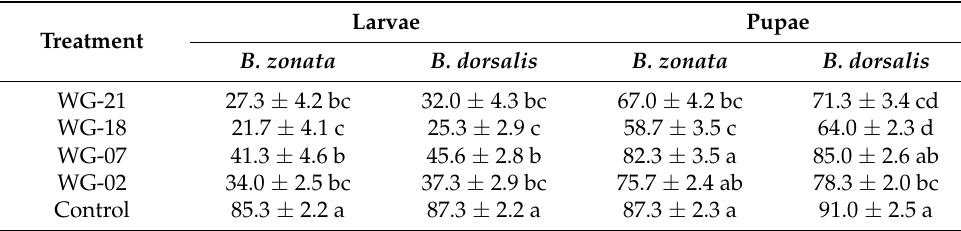
Table 10. Percent adult emergence (mean ± SEM) in B. zonata and B. dorsalis when four isolates (WG-21, WG-18, WG-07, and WG-02) of entomopathogenic fungi were applied against third in- star larvae and pupae in greenhouse trial. Same letters within the column indicate no significant differences between treatments ( p < 0.05; Tukey HSD test).